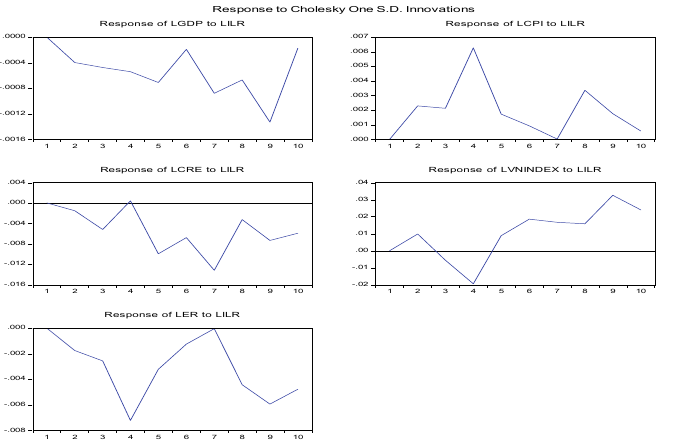
Fig. 6. Impact of average loan interest rate shock on endogenous variables GDP, CPI, ER, VN-INDEX,